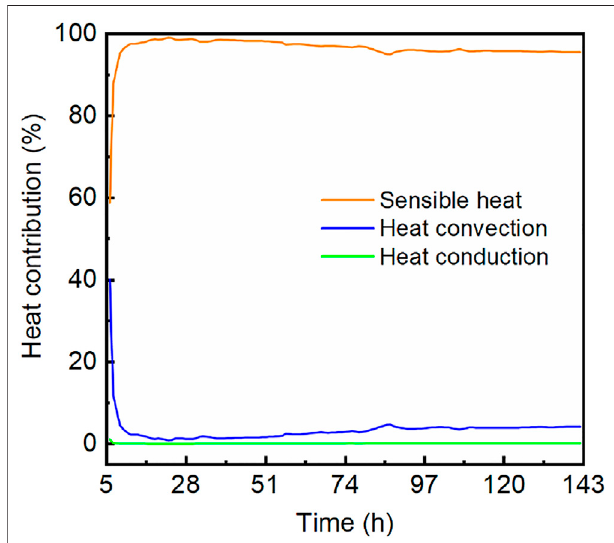
FIGURE 8 | Contributions of sensible heat, heat convection, and heat convection to hydrate dissociation.